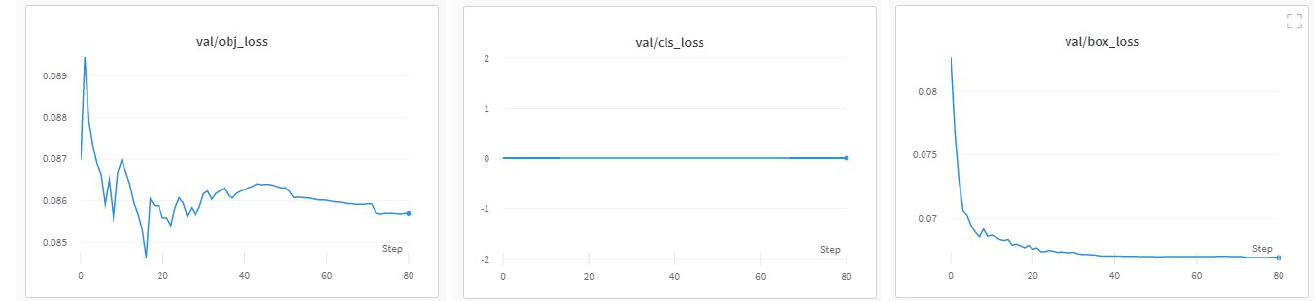
Figure 10. Training set metrics.